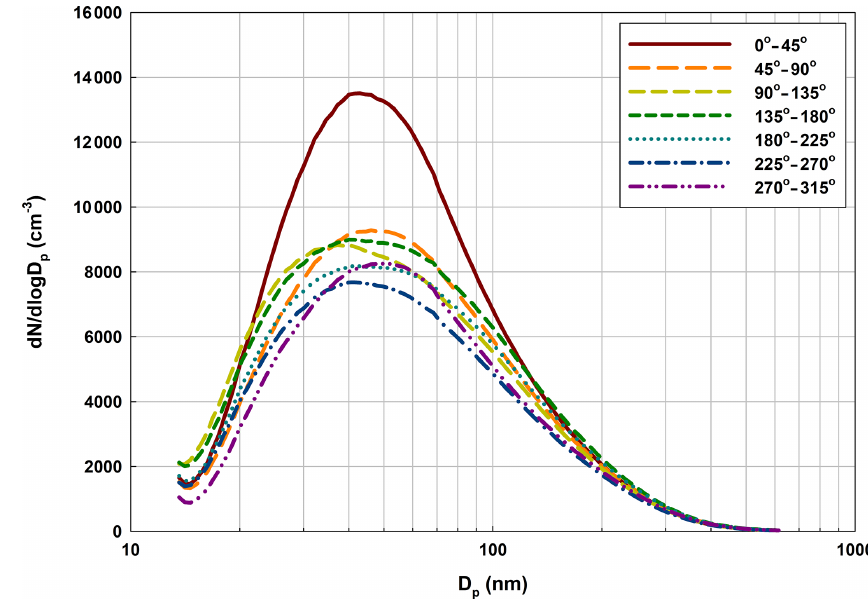
Figure 4. Mean particle number size distributions by each sector of wind directions with an interval of 45 ◦ during 2012–2019. Table 2. Mean values of particle number in the three modes ( N 13 − 25 , N 25 − 100 and N 100 − 800 ), AOD, the concentrations of six criteria air pollutants (PM 2 . 5 , PM 10 , O 3 , SO 2 , NO 2 and CO) and the condensation sink (CS) for each